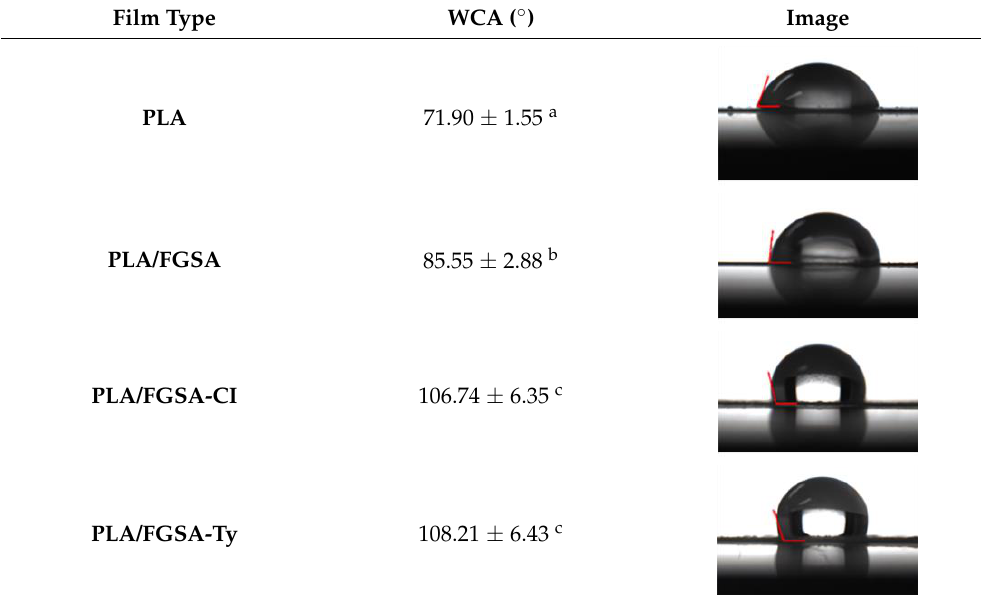
Table 2. Water contact angle of films (PLA, PLA/FGSA, PLA/FGSA-CI, and PLA/FGSA-Ty).